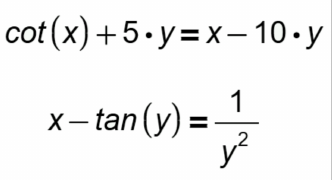
Figure 1. System of two trigonometric equations on a worksheet in